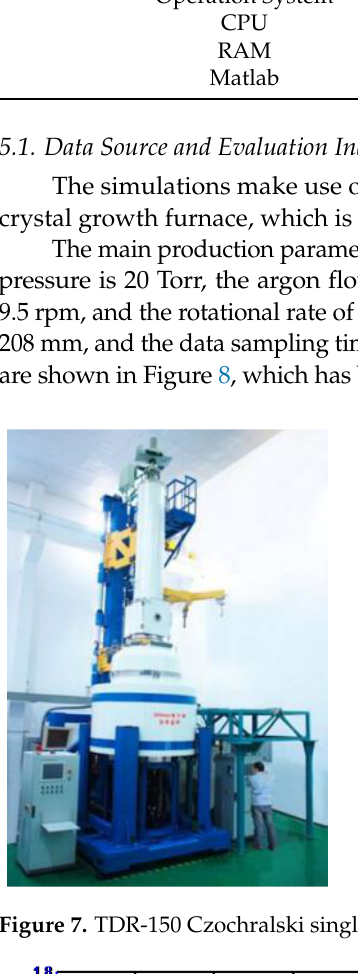
Figure 7. TDR-150 Czochralski single-crystal growth furnace.